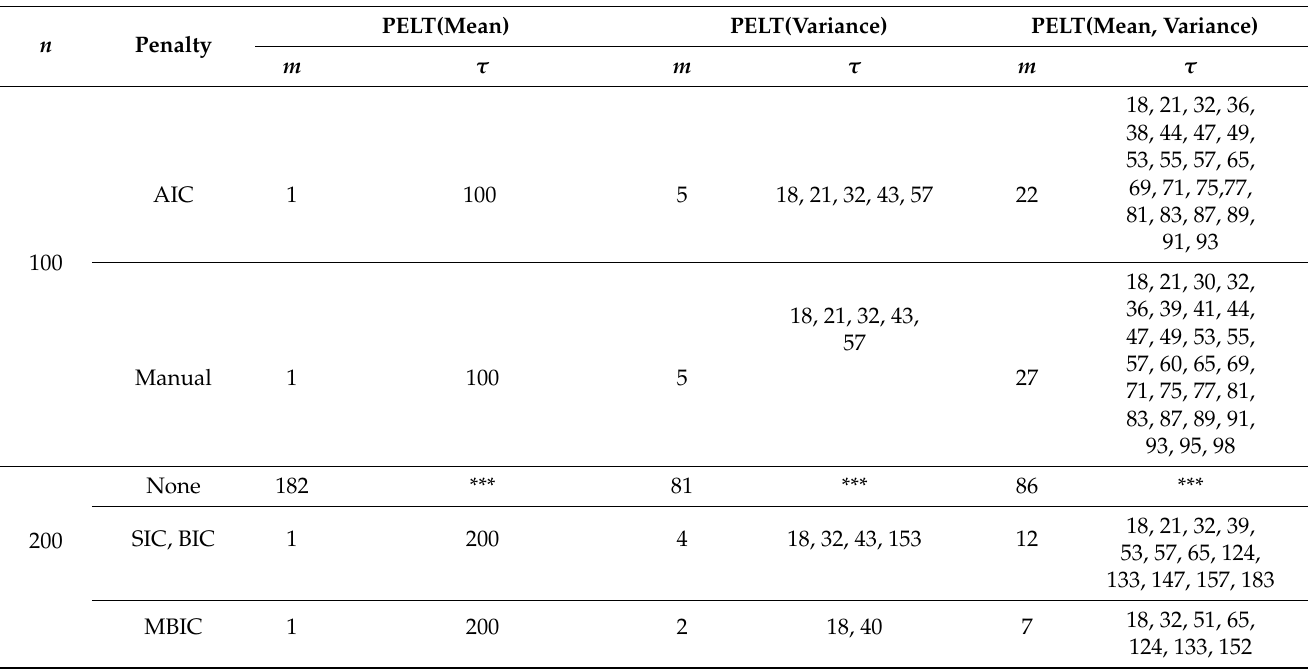
Table A10. PELT Algorithm Result for Poland’s COVID-19 Transmissibility